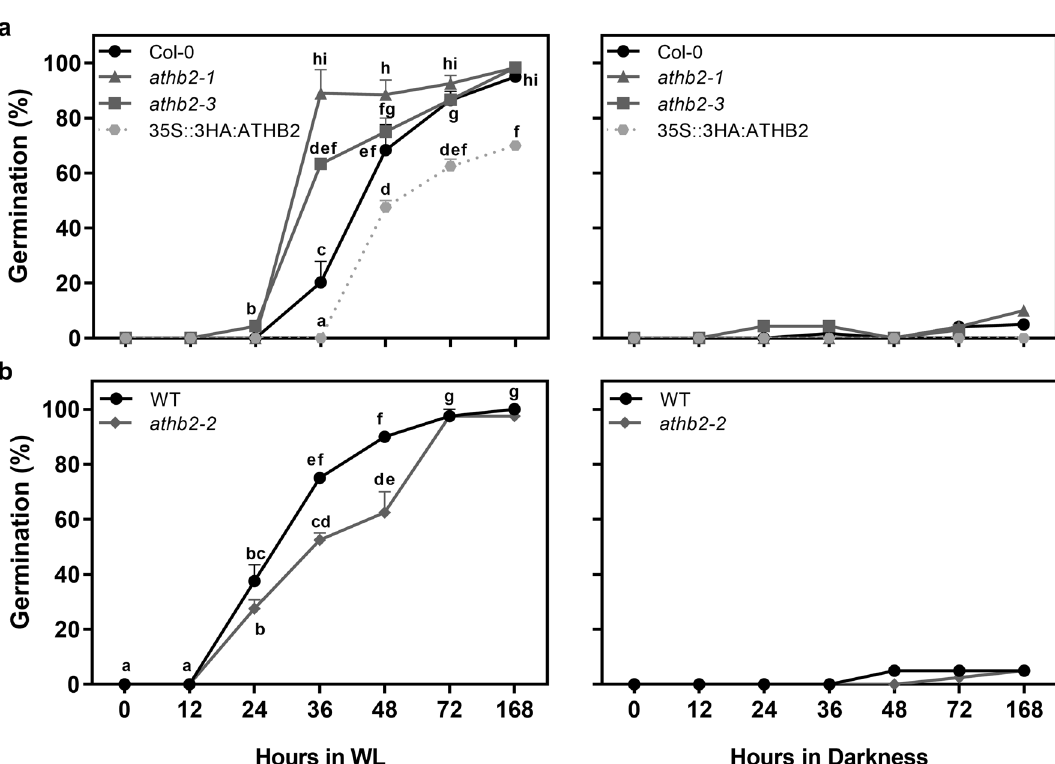
Figure 4. ATHB2 delays seed germination under continuous white light. Seeds were sown for 2 h in darkness (D) and then irradiated with a Far-Red pulse (FRp). Seeds were then incubated for 72 h at 5 °C in D and then incubated at 22 °C under continuous white light (WLc). Germination was counted during variable times upon light irradiation. ( a , b ) Germination of Col-0, loss-of-function ( athb2-1 ; athb2-3 ) and gain-of-function (35S::3HA:ATHB2; athb2-2 ) seeds incubated for 72 h at 5 °C, previous to light exposure. Right panels represent the darkness control. Each point represents mean ± SE (n ≥ 6). Significant differences between means are shown with different letters ( p < 0.05 by ANOVA followed by Fisher post